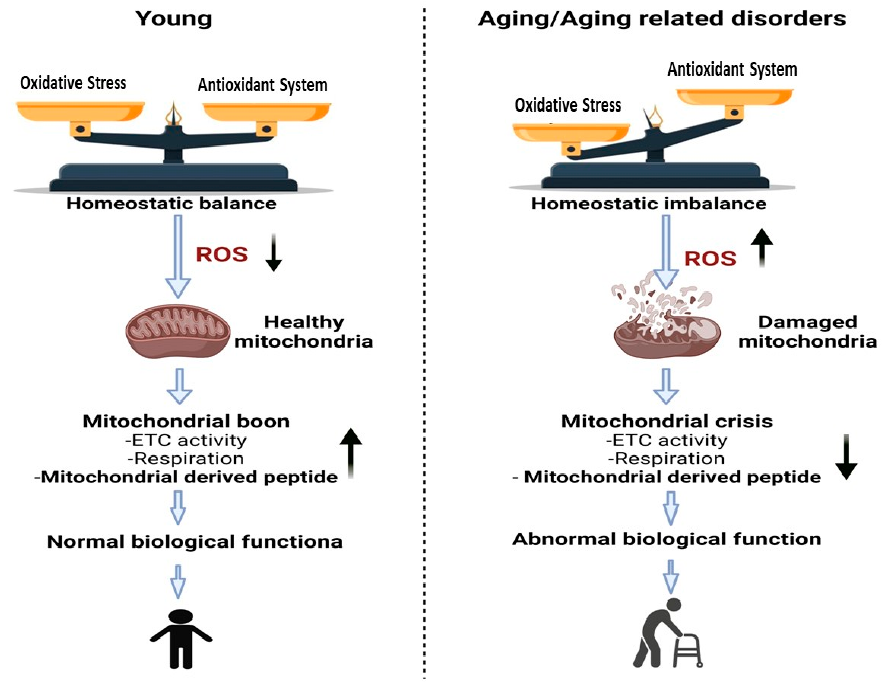
Figure 1. Changes that occur in mitochondria due to aging or aging related disorders are associated with a reduction in the function of mitochondria. Due to the accumulation of mutations and the oxidative damage generated by reactive oxygen species (ROS), the mitochondrial DNA volume, integrity, and functionality all decline with advanced. Left Panel represents young individuals with balanced homeostasis leading to normal biological functions of tissues. Right Panel represents greater levels of oxidative stress that lead to increased ROS and mitochondrial dysfunction along with abnormal biological functions.